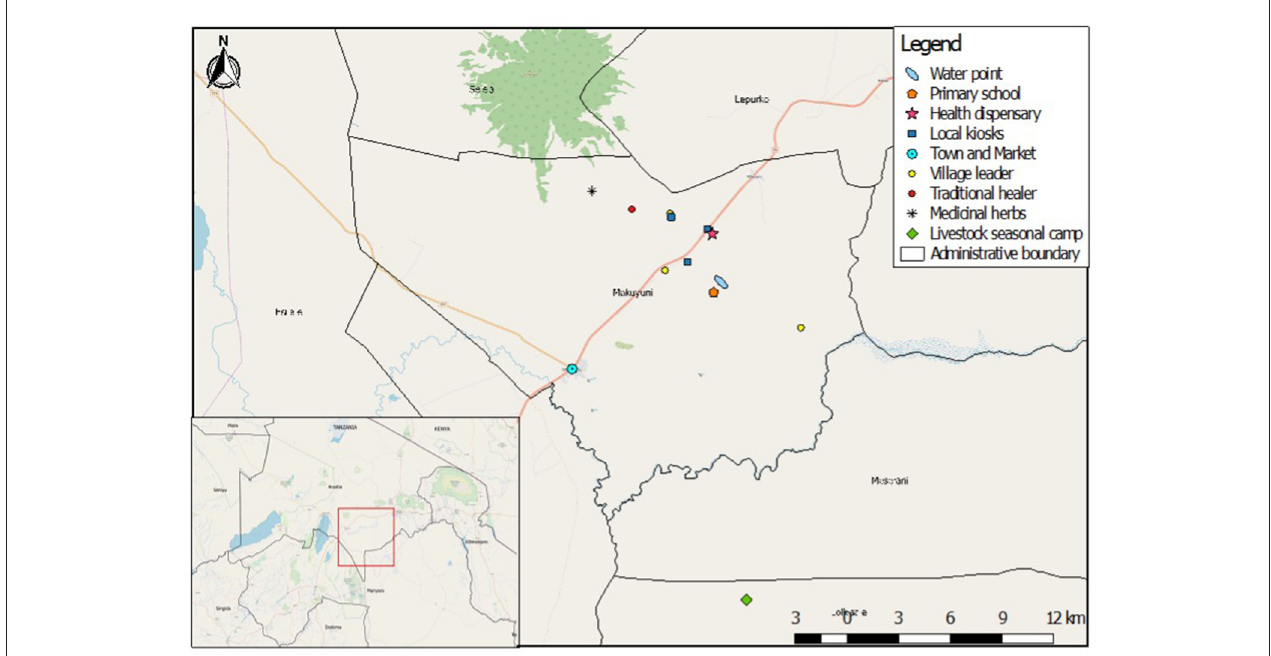
FIGURE 1 | Map of Naiti village with markings indicating important